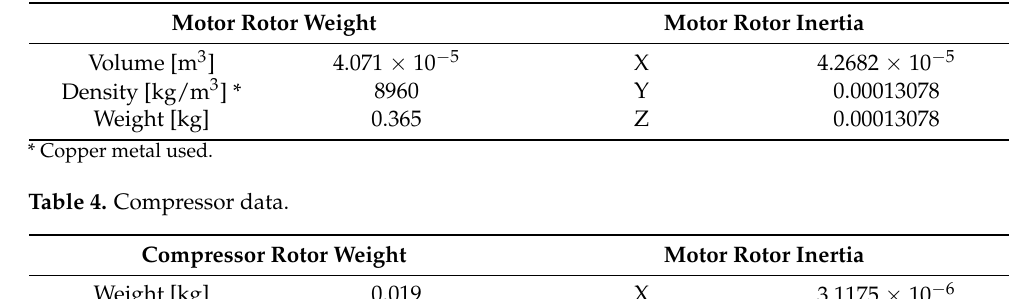
Table 3. Rotor characteristics.